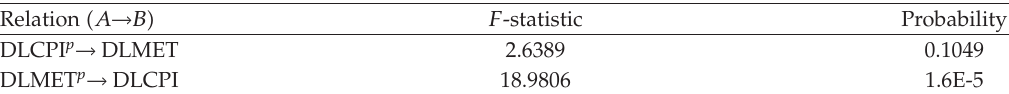
Table 2: Test for nonlinear causality (cid:5) asymmetric case for positive returns (cid:6) . If P > . 05, then at 5% we accept the null hypothesis that A does not cause B . The parameters for the M-G model were τ 1 (cid:8) 3, τ 2 (cid:8) 1, and (cid:8) c (cid:8) 2. c 1 2